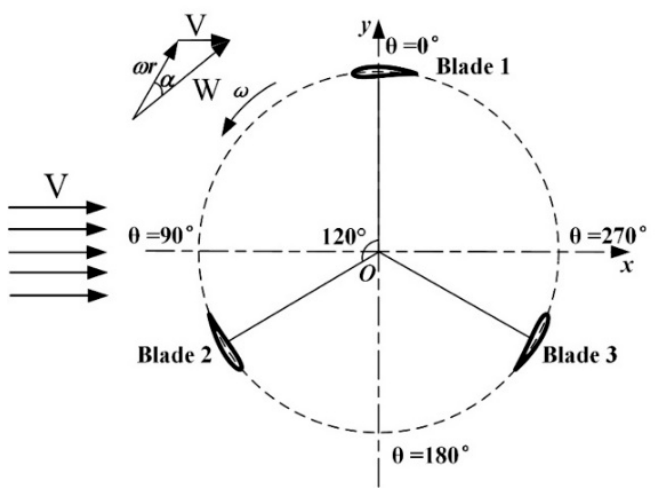
Figure 5. Phase angle and motion analysis of each blade.